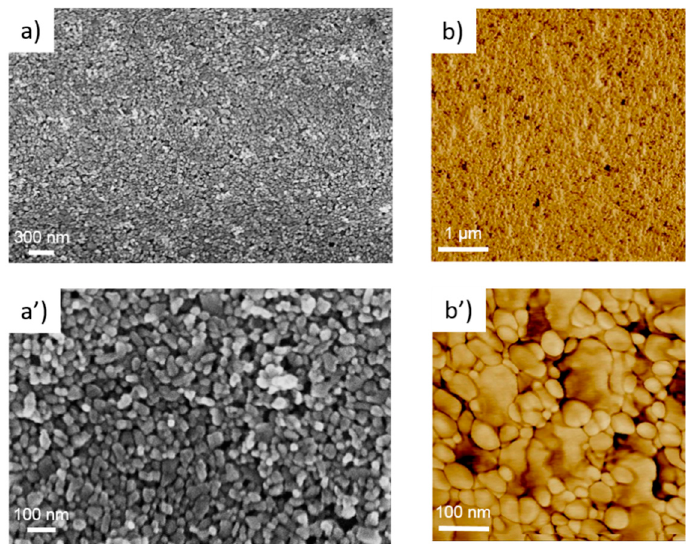
Figure 2. ( a ) SEM image; ( a’ ) magnified SEM image; ( b ) AFM phase image; ( b’ ) magnified AFM phase image of the as-printed (non-sintered) ZnO seed layer.